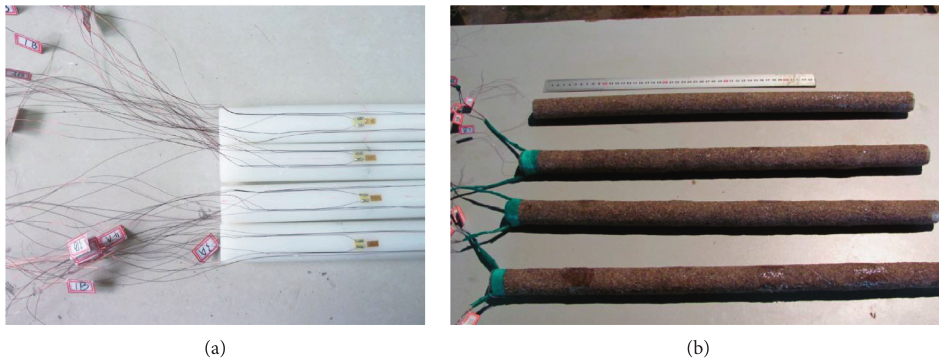
Figure 2: Treatment of the model pile (strain gauge sticking and sand wrapping).